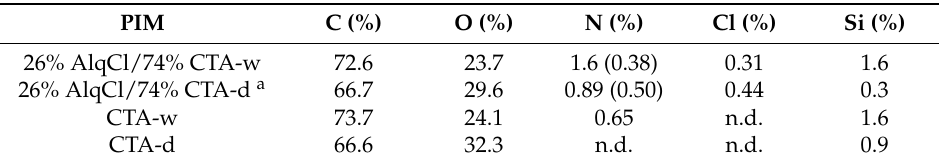
Table 1. Atomic concentration percentages of the elements found * on the surfaces of wet (X-w) and dry (X-d) PIM or CTA film.